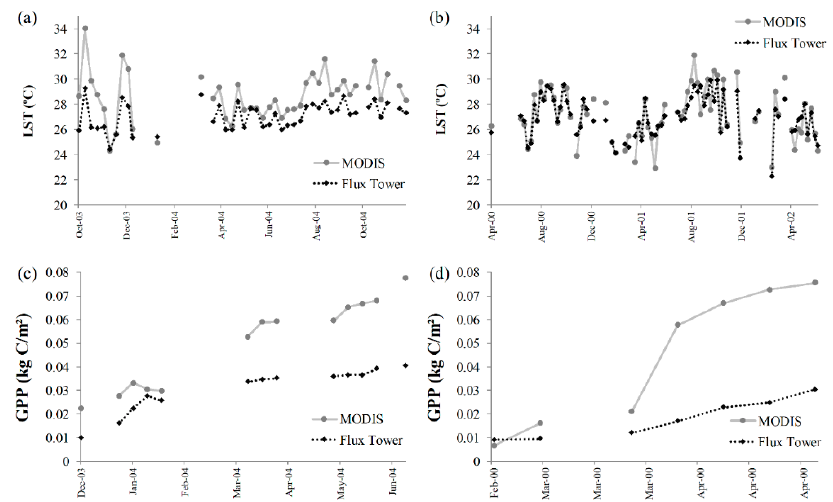
Figure 4. Comparison between MODIS data and flux towers of the Large-Scale Biosphere-Atmosphere project for ( a ) land-surface temperature (LST) in the Araguaia National Park and Cantão State Park (ANP-CSP), ( b ) LST in the Ji-Paraná River Basin (JPRB), ( c ) Gross Primary Productivity (GPP) in the ANP-CSP area, and ( d ) GPP in the JPRB area.